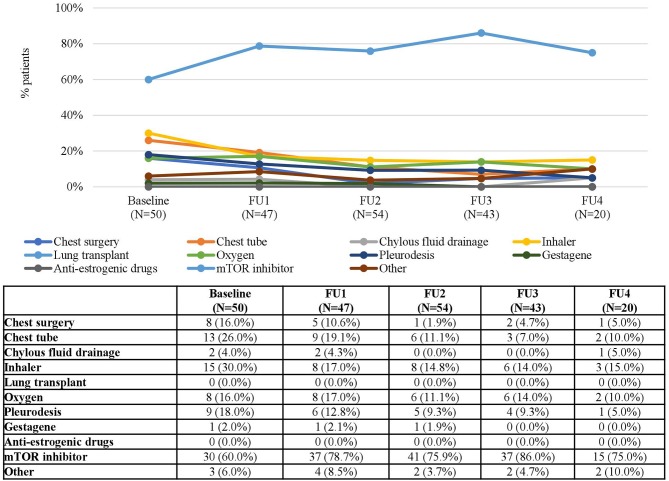
LAM Treatments according to Follow-Up. Patients may receive more than one treatment. Baseline data refers to patients who “ever had” the manifestation.